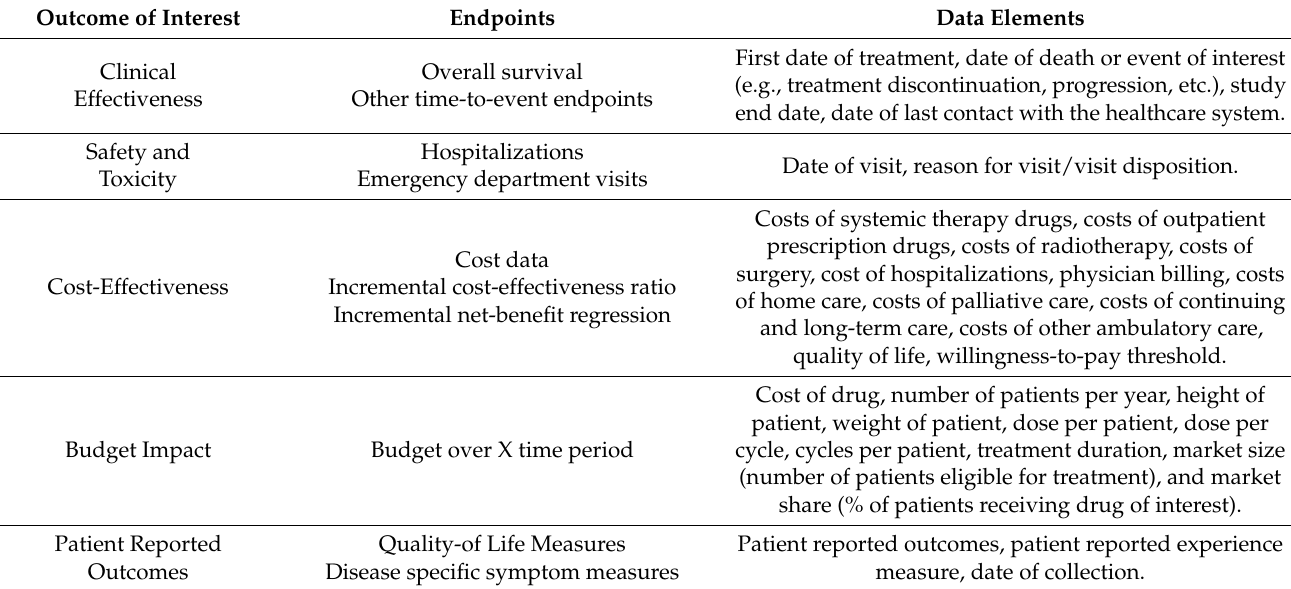
Table 2. Outcomes of interest for conducting a real-world